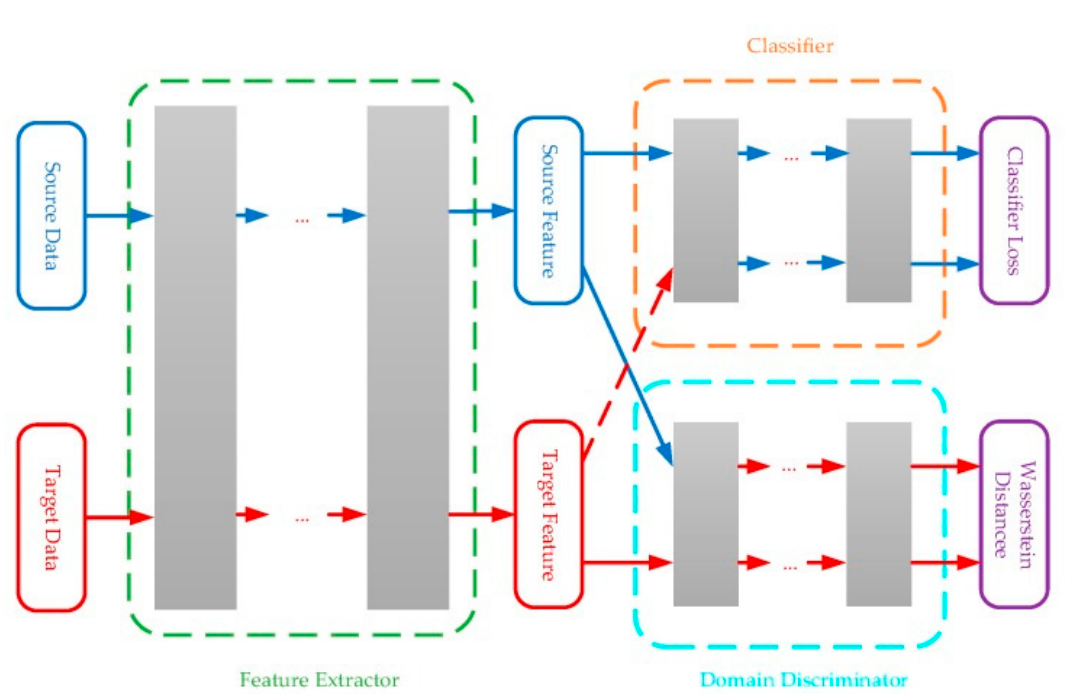
Figure 14. Adversarial training framework for gas sensor drift compensation [116].